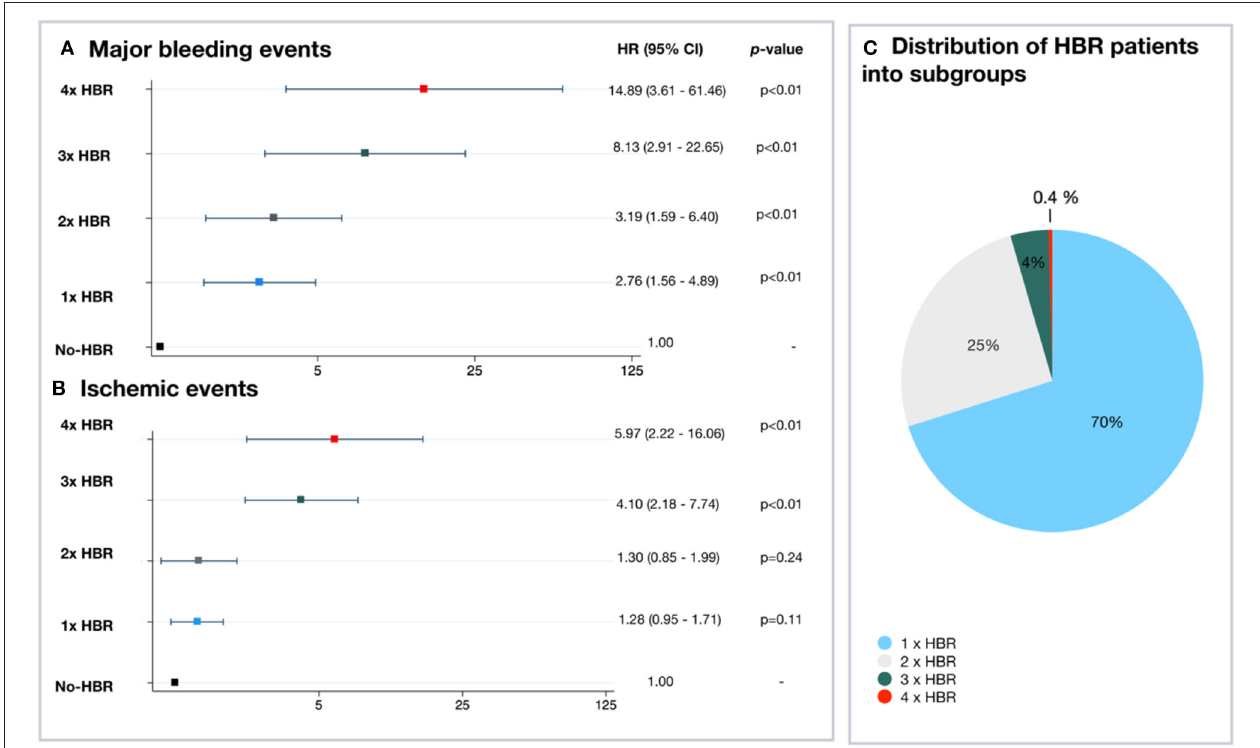
FIGURE 3 | Incremental risk of major bleeding and ischemic endpoints according to the number of ARC-HBR criteria. (A,B) Risk of major bleeding and ischemic endpoints at 2 years for each HBR subgroup. (C) Distribution of HBR patients into subgroups. ARC, Academic Research Consortium; CI, confidence interval; HBR, high bleeding risk; HR, hazard ratio; LBR, low bleeding